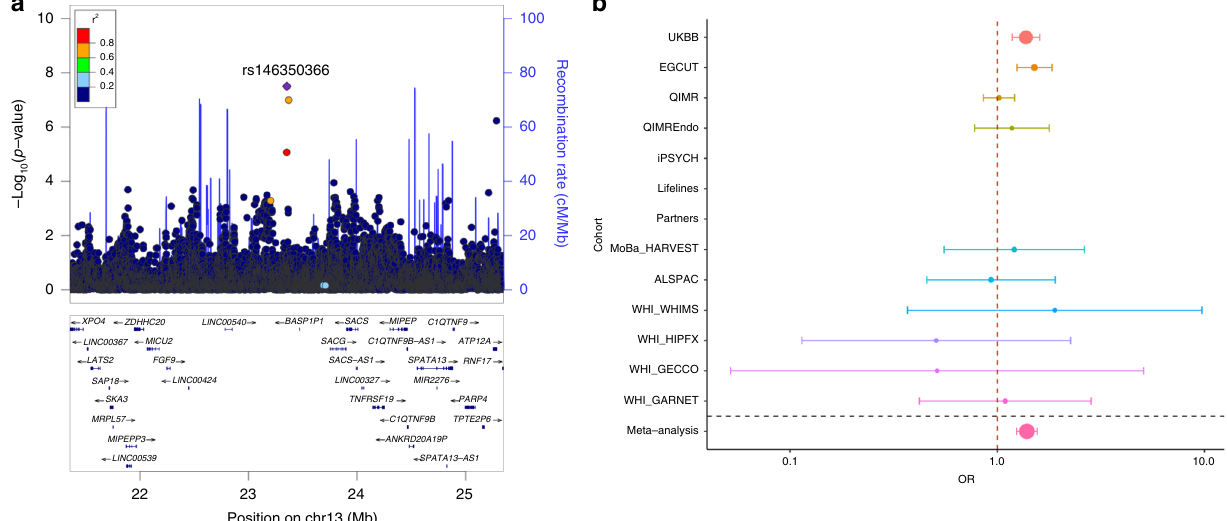
Fig. 2 Results of the sporadic miscarriage European ancestry GWAS meta-analysis. a We detected one genome-wide signi fi cant locus on chromosome 13 (lead signal rs146350366, n cases = 49,996, n controls = 174,109). The 1000G EUR reference was used for plotting. b The forest plots depict effect estimates in individual cohorts and the size of the dot is proportional to effective sample size (calculated as 4/((1/N_cases) + (1/N_controls))). Error bars depict 95% con fi dence intervals. Dashed red line indicates the line of no effect. Details of association testing in individual cohorts can be found in Supplementary Data 2. Summary effect estimate from inverse variance fi xed effects